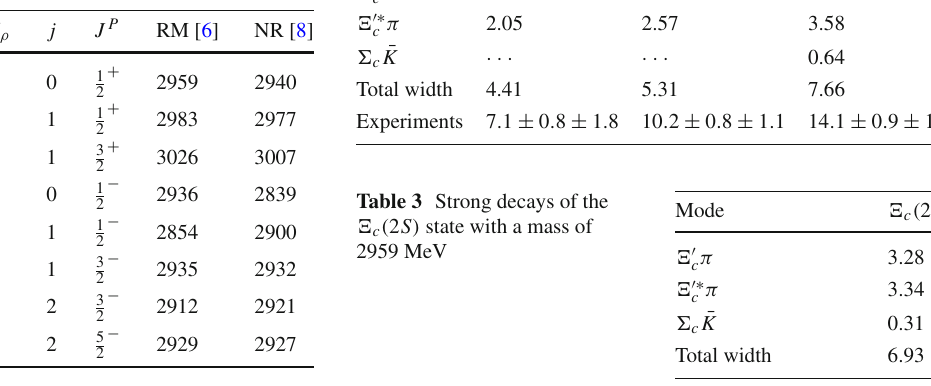
Table 1 Notations, quantum numbers, and the predicted masses of the relevant states. The n λ and l λ are the nodal quantum number and orbital angular momentum between the light quark subsystem and the charm quark, respectively. L , S ρ , and j stand for the total orbital angular momentum, total spin of the two light quarks, total angular momentum of L and S ρ , respectively. J P represent the spin-party of the hadron. The units are in MeV